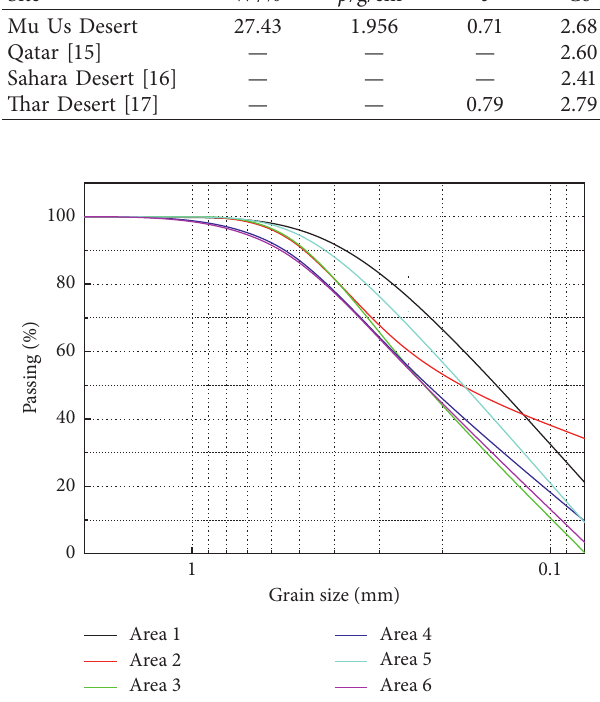
Figure 3: Grain distribution.